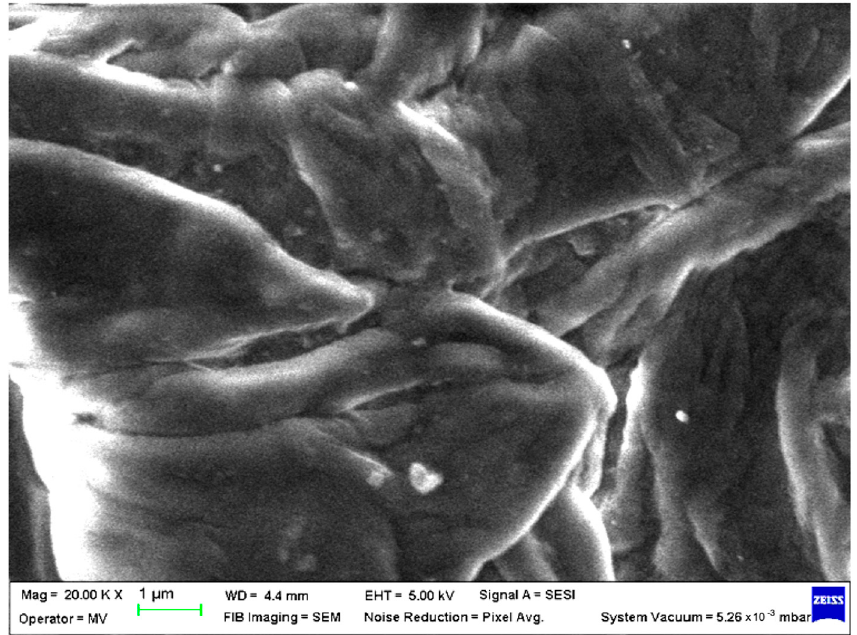
Figure 11. SEM micrographs of PET–HDPE composite (M11) sample at T 0 (1 μ m scale).